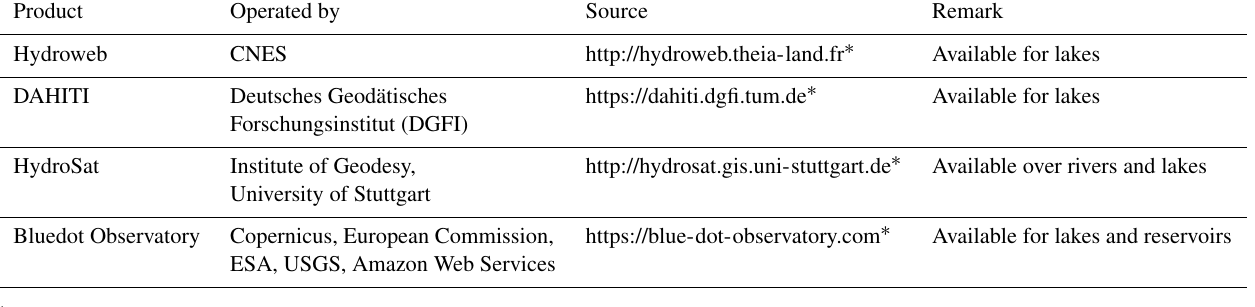
Table 2. List of sources for providing time series of surface water extent from satellite imagery.